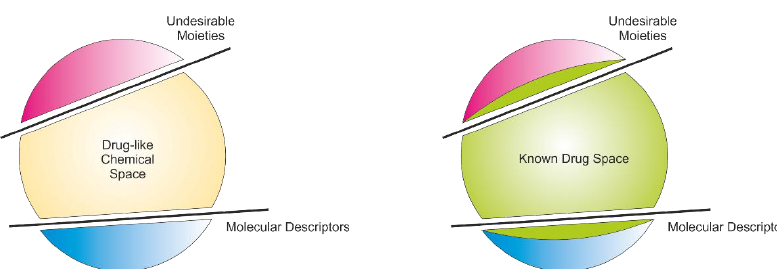
Figure 1. A graphical representation of chemical space reduced with undesirable moieties and molecular descriptors in defining drug-likeness. Known drug space occupies larger volume in chemical space [17].